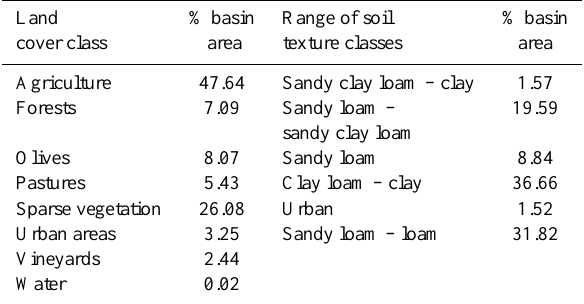
Table 2. Land cover and range of soil texture classes used as input for the tRIBS model, with the corresponding percentage of basin